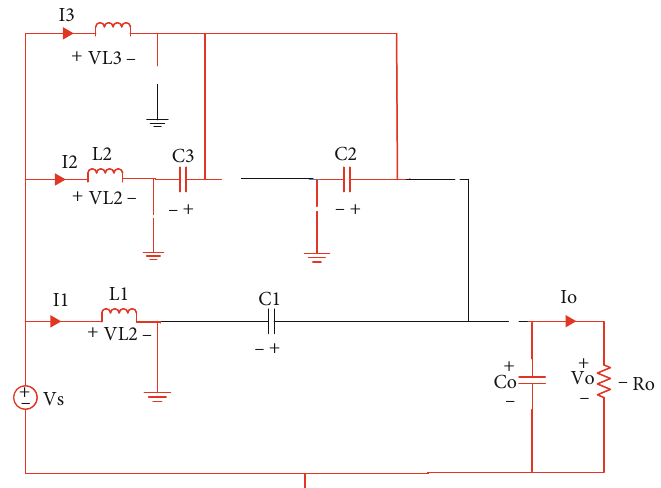
Figure 4: States I, III, and V.